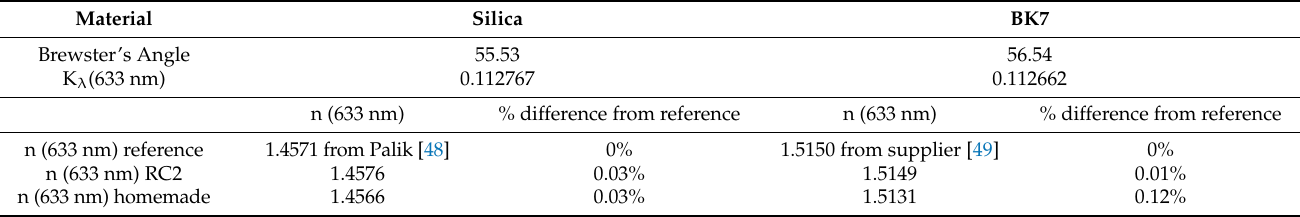
Table 1. Summary of different results from Figure 8 and the calculated value of the coefficient K λ .